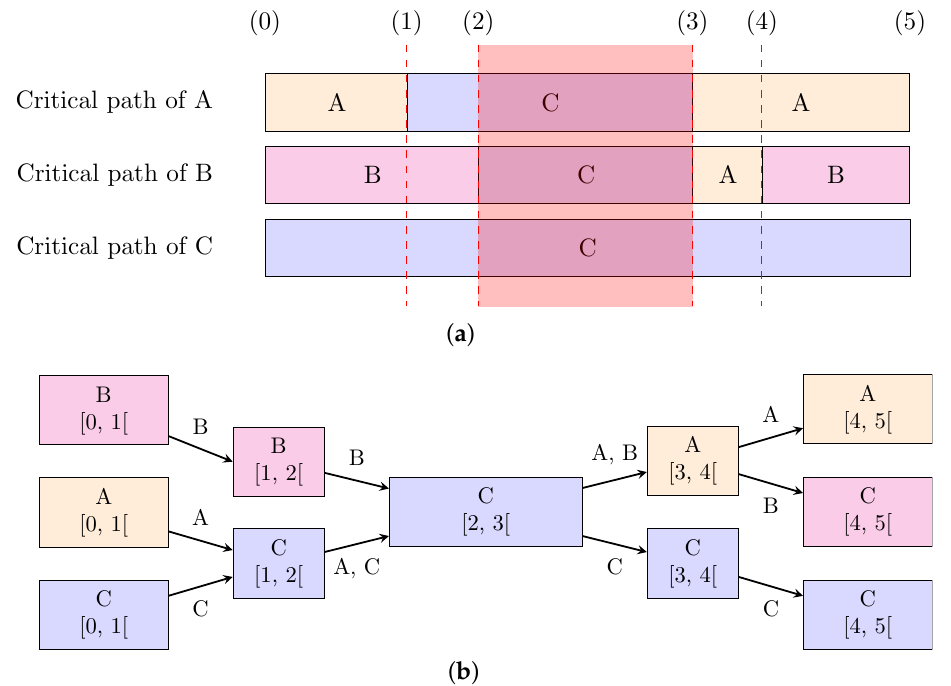
Figure 6. Shared states between different thread critical paths. The critical paths of different threads can share one or more states ( a ). In this example, the thread C initially holds a mutex M and threads A, B and C are running. Each block indicates which thread is on the critical path of the thread of interest. (Solid lines indicate requesting, acquiring or releasing a lock on a resource). The critical paths are built according to the sequence of the following events: (0) trace begins, (1) A requests locking M, (2) B requests locking M, (3) C releases M and A locks M, (4) A releases M and B locks M, and (5) trace ends. (It is important to note that execution continues even after releasing a lock). The red overlay in subfigure ( a ) highlights the interval during which all threads have the same state in their respective critical path. Our critical path merging algorithm outputs the graph in subfigure ( b ). Each graph node indicates which thread the state refers to, as well as the time interval of the state. The critical path of a given thread can be recovered back from the graph by following the edges labelled with that thread